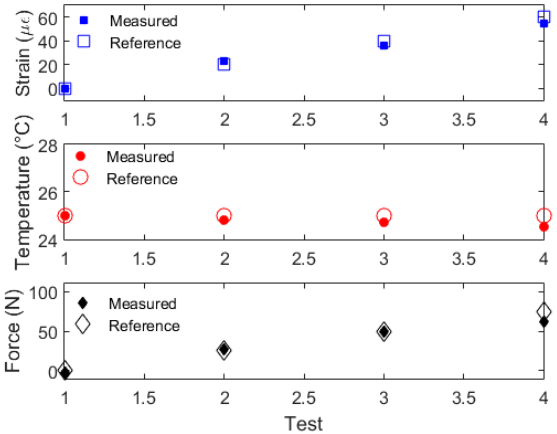
Figure 7. Strain, temperature and force estimations with the proposed FBG embedded in a Figure7. Strain, TPU structure.